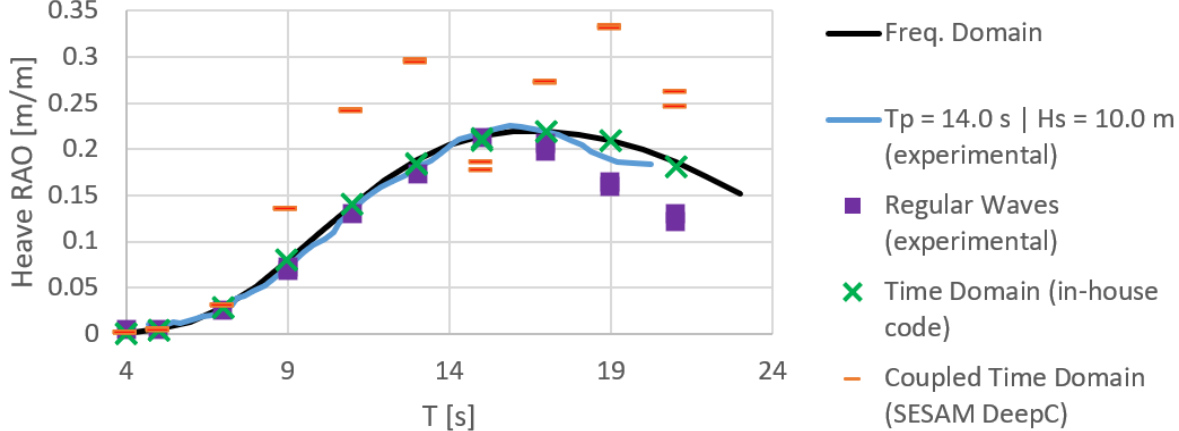
Figure 7. Heave RAOs according to different methods.